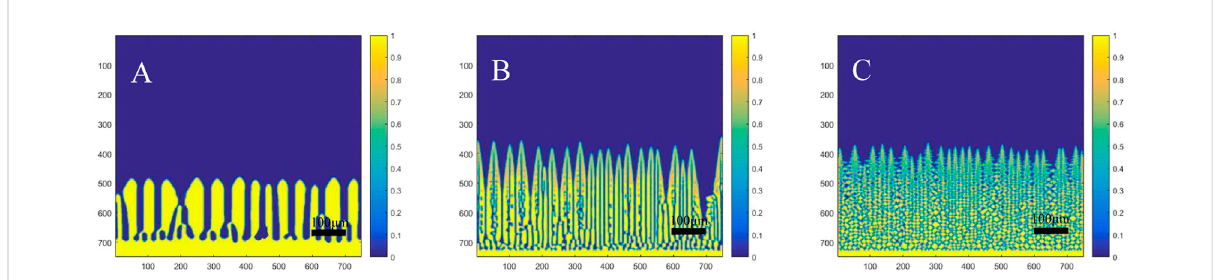
Effect on dendrites morphology by anisotropy: (A) γ (cid:1) 0 . 04; (B) γ (cid:1) 0 . 05; (C) γ (cid:1) 0 .